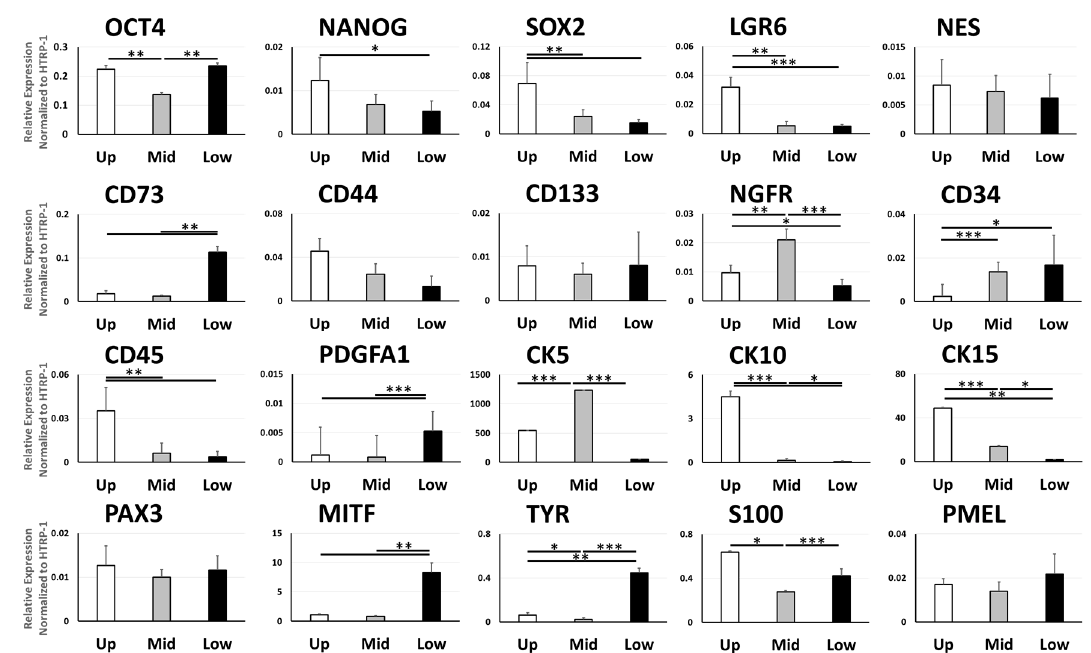
Figure 3. Expression of the heterogeneous gene pool in the plucked hair follicles at the level of the distal (Up), middle (Mid), and proximal (Low) ORS compartments (N = 7). Results were shown as a mean ± SEM. Comparison between groups was statistically analyzed by unpaired student’s t-test. Statistical significance: * p < 0.05, ** p < 0.01, *** p < 0.001.